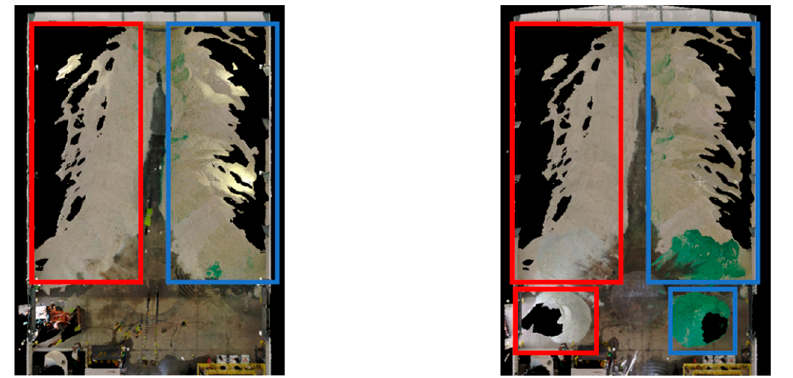
Figure 30. Top view of RGB color-coded point clouds from the TLS, acquired before/after salt repo-